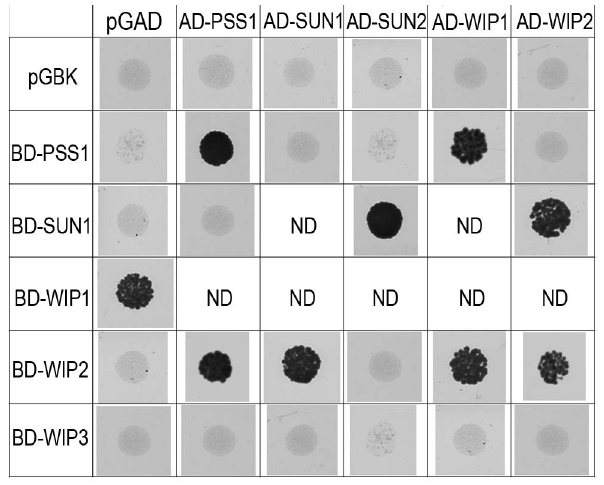
Figure 9. Interaction between AtPSS1, AtWIPs and AtSUNs. Yeast two-hybrid - For each combination yeast cells were spotted on selective medium to test interactions (all combinations were able to grow on non-selective medium; not shown) ND: Not determined either because irrelevant or due to self-activation of one of the partners. (FLAG_026E12). Details for all genotypes, primers used and PCR amplification conditions are shown in table S2.